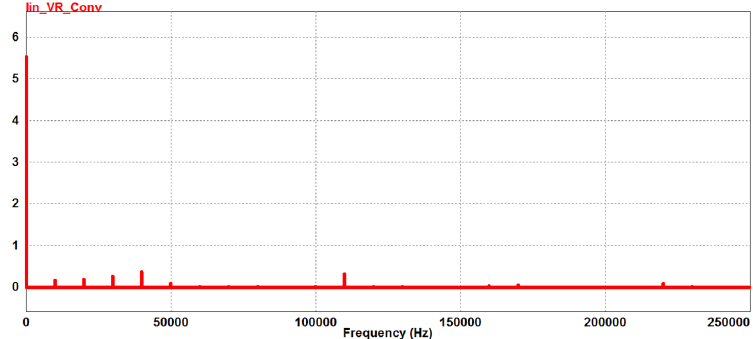
Figure 16. FFT analysis of the input current waveform of an IH system with a conventional VR.